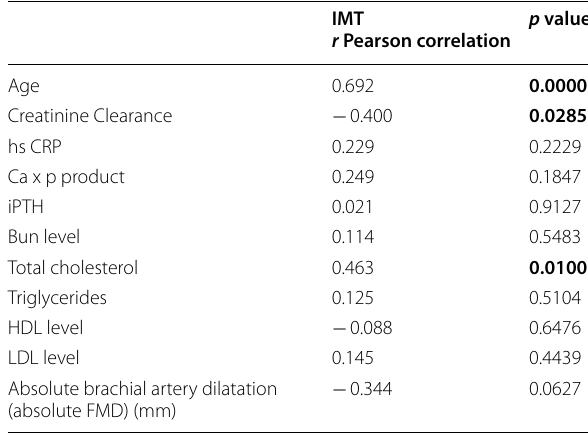
Table 3 Correlation between Framingham risk score, creatinine clearance, inflammation, and laboratory data in CKD